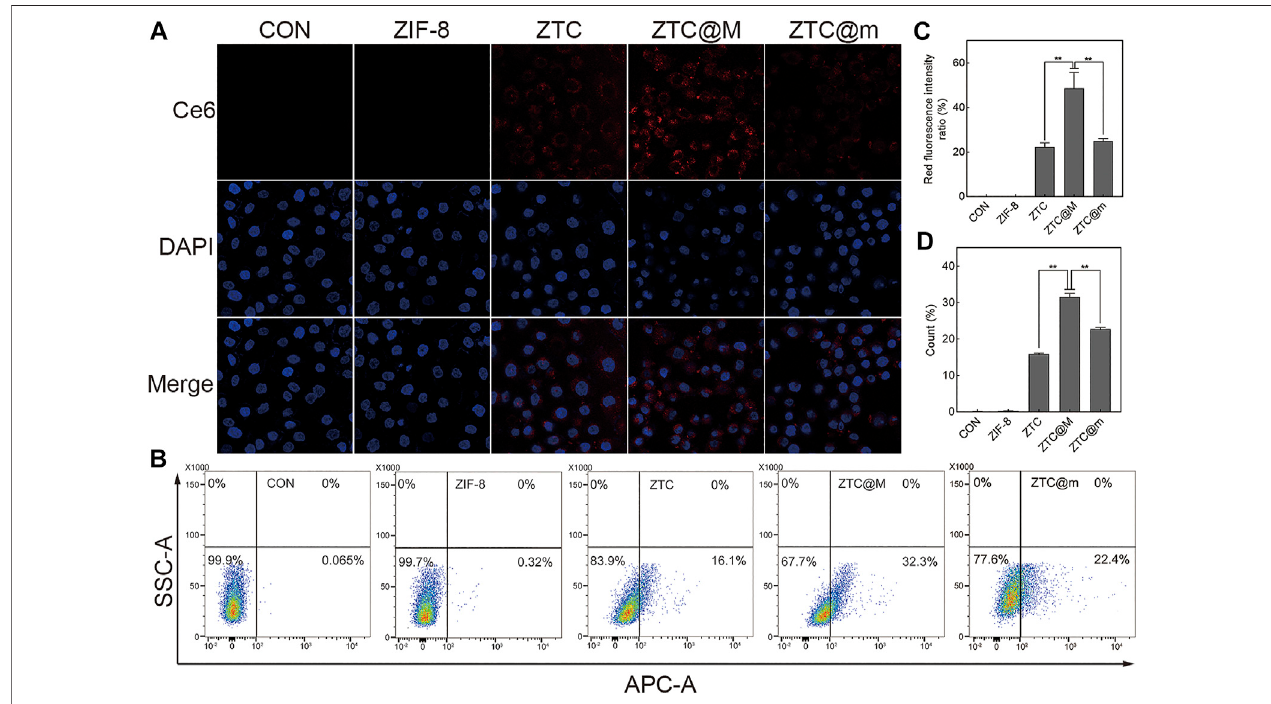
FIGURE4| Cellularuptakeexperiments.Fluorescenceimaging (A) and fl owcytometry (B) ofAGScellsincubatedwithdifferentnanoparticles(600×).Quanti fi cation of intracellular Ce6 fl uorescence intensity in A (C) . Count of AGS cells with intracellular fl uorescence of B (D) . * p < 0.05, ** p < 0.0001.